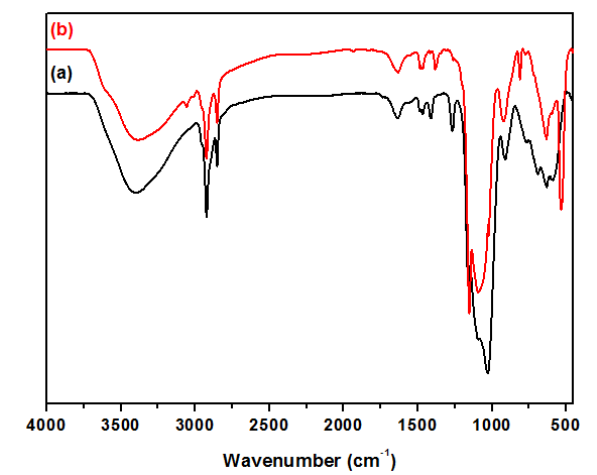
Figure 8. IR spectra of ( a ) M-Ethylene PMO NPs and ( b ) M-Phenylene PMO NPs.